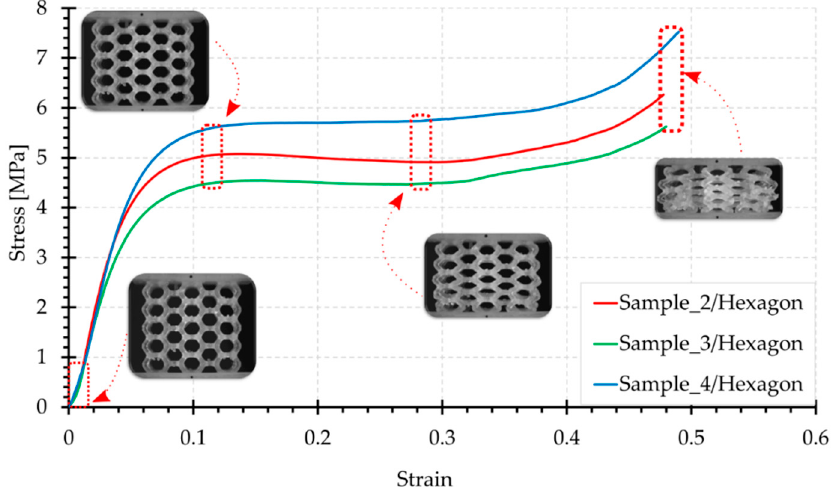
Figure 7. Compression curve for the Hexagon structure with photographs of the topology at selected test phases.